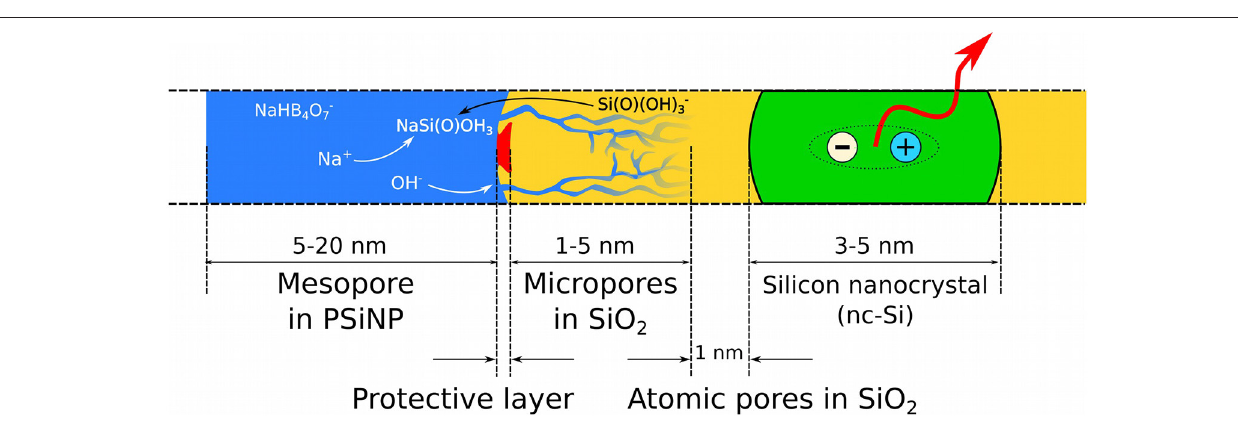
FIGURE 9 | Schematic cross-section of a PSiNP subjected to borax-induced oxidation/dissolution. Borax solution (blue) penetrates into the SiO 2 shell (yellow), which covers the silicon core silicon nanocrystallite (green). An exciton confined in the silicon nanocrystallite is shown as ≪ + ≫ and ≪ – ≫ in circles and photoluminescence is indicated with the red arrow. A notional insoluble protective surface layer is shown as a red